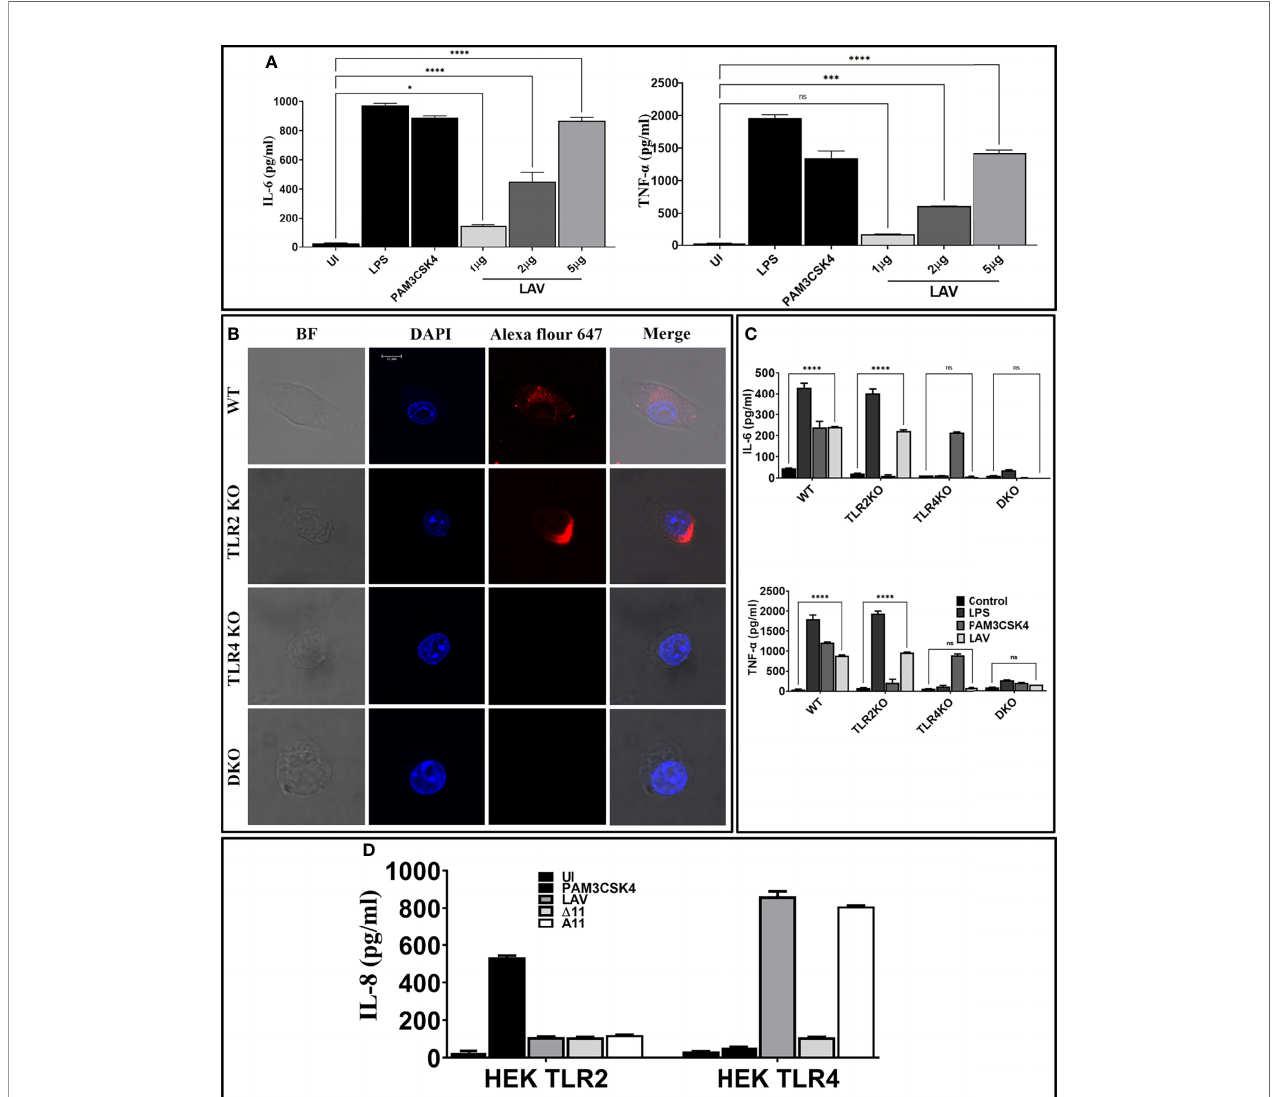
FIGURE 1 | Variable region of LigA (LAV) induced TLR4 dependent activation of mouse macrophages. (A) Screening of pro-in fl ammatory response of LAV in RAW264.7 cells. RAW264.7 cell lines were stimulated with LAV in varying concentrations 1 or 2 or 5 m g/ml along with PMB for 24h and supernatant was collected to measure levels of TNF- a and IL-6 cytokines by using ELISA. (B) Binding of LAV with TLR4. WT, TLR2KO, TLR4KO, or DKO macrophages were incubated with LAV (2 m g/ml) for 30 min. After washing, cells were fi xed and stained with then stained with Alexa Flour 647 conjugated rabbit anti-mouse IgG and analysed by the confocal microscope as described in materials and methods. (C) Pro-in fl ammatory response of mouse macrophages stimulated with rLig proteins with LAV. WT, TLR2KO, TLR4KO and DKO macrophages cell lines were treated LAV at 2 m g/ml for 24h at 37°C in presence of 5%CO 2 and levels of IL-6 and TNF- a in the supernatants were measured by ELISA. (D) IL-8 response in HEK293-TLR4 cells stimulated with LAV . HEK293T cells transfected with TLR2, TLR4 and NF-kB reporter plasmids were stimulated with LAV (2 m g/ml) for 24h and IL-8 was measured in the culture supernatant by ELISA. E. coli LPS (500ng/ml) or PAM3CSK4 (20ng/ml) as TLR4 and TLR2 ligands respectively were used as positive controls in all experiments wherever indicated. Data are representative of three different experiments. Signi fi cant differences were calculated using the one or two way ANOVA (****, ***, *, ns indicates P < 0.0001, < 0.001, P < 0.05 and non- signi fi cant